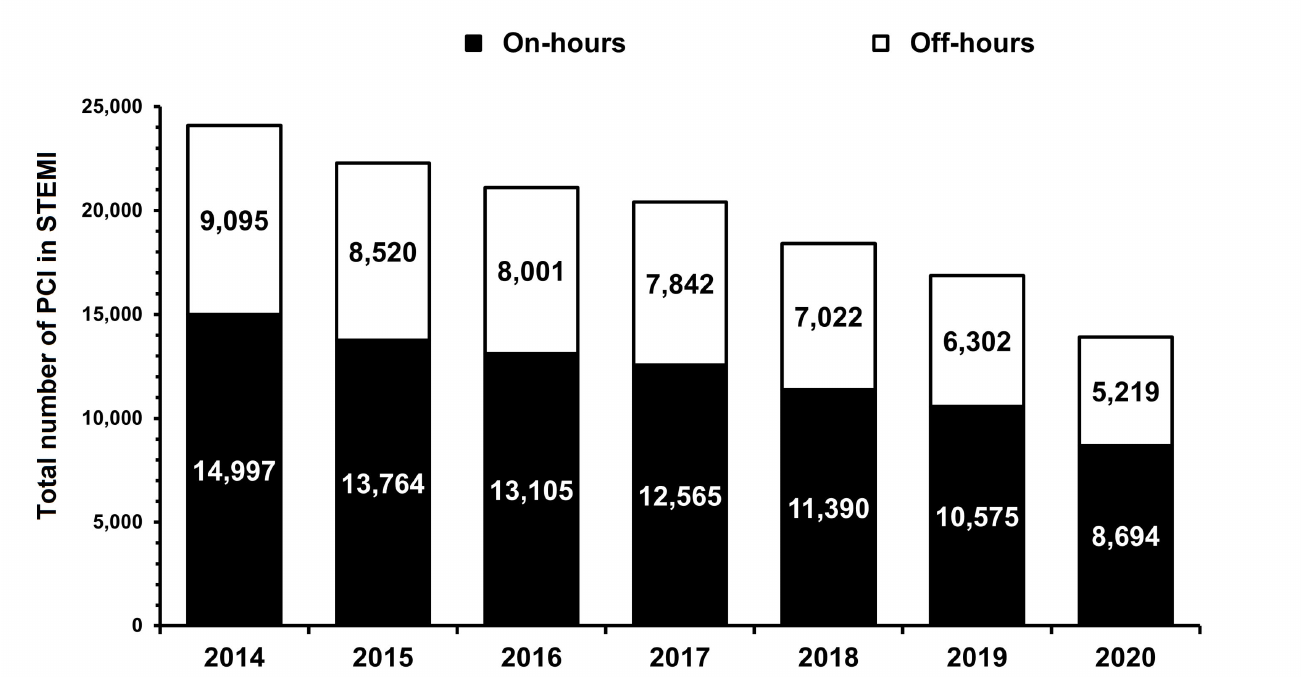
Figure 2. Total number of hospitalizations for PCI in STEMI for both on- and off-hours ( p = 0.001). PCI—percutaneous coronary intervention; STEMI—ST-segment elevation